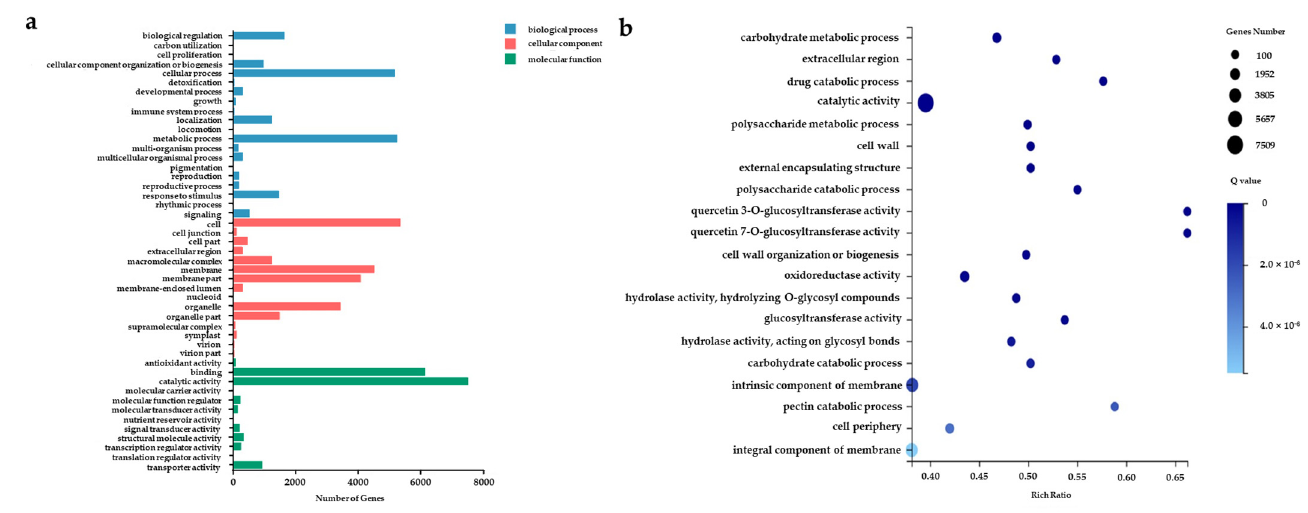
Figure 6. GO analysis of DEGs. ( a ) GO classification of DEGs. ( b ) GO enrichment of DEGs.